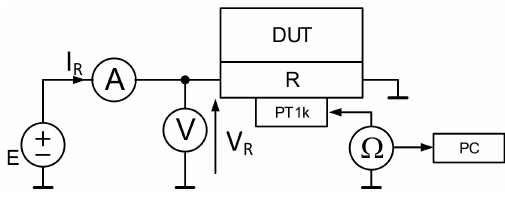
Figure 1. General scheme of the experimental